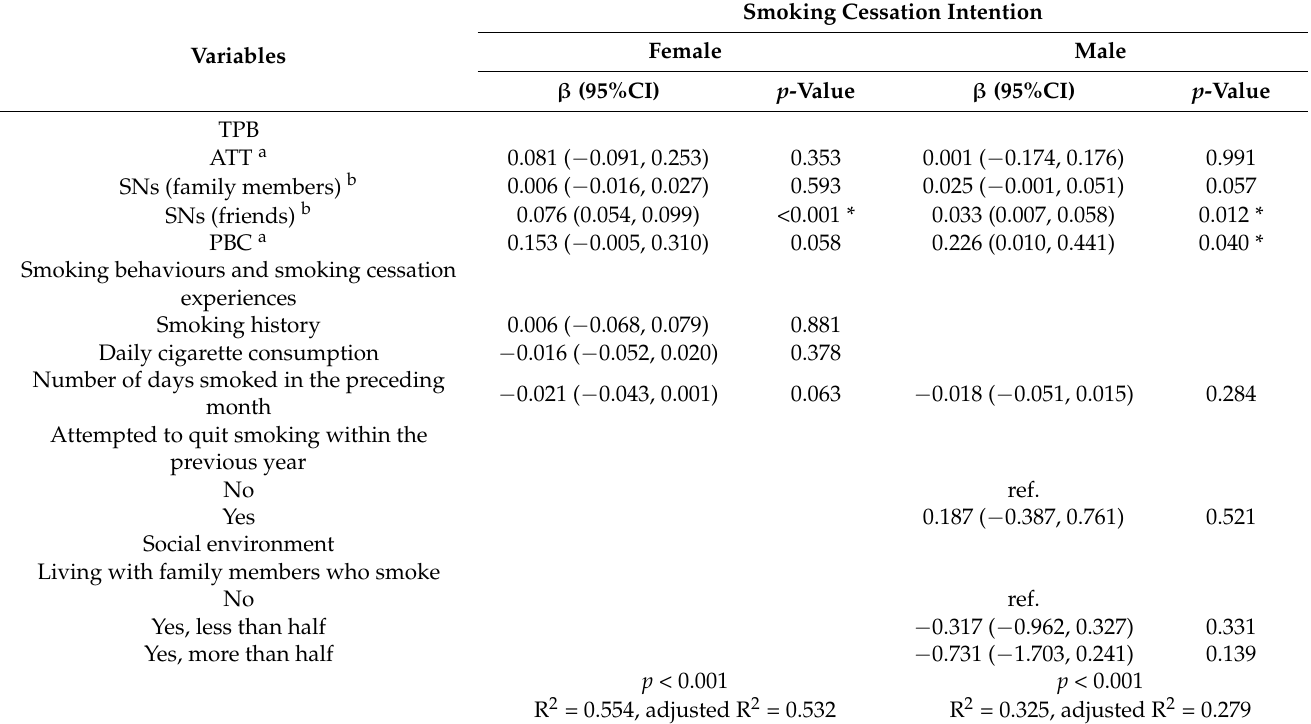
Table 4. Multivariable linear regression of smoking cessation